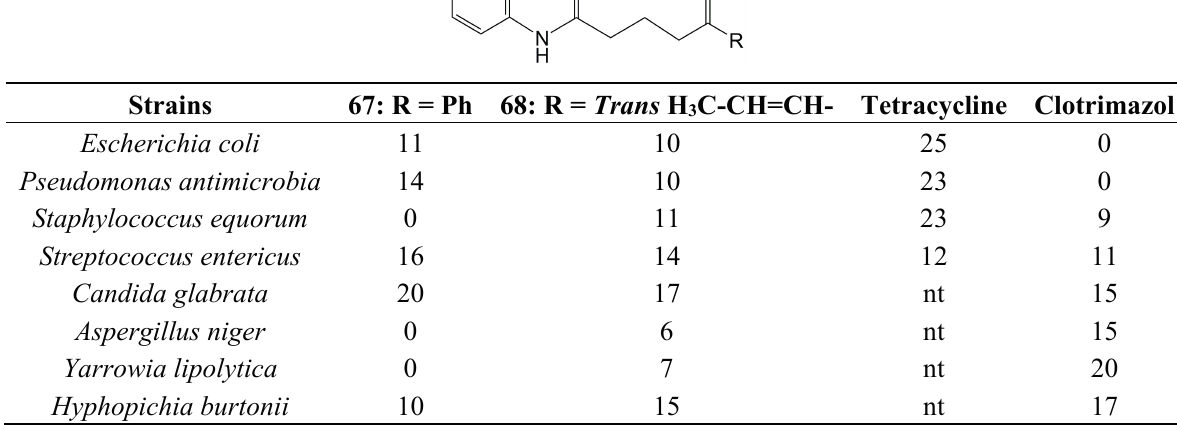
Table 1. Agar diffusion assay for compounds 67 , 68 , tetracycline and clotrimazol (50 mg/disc).